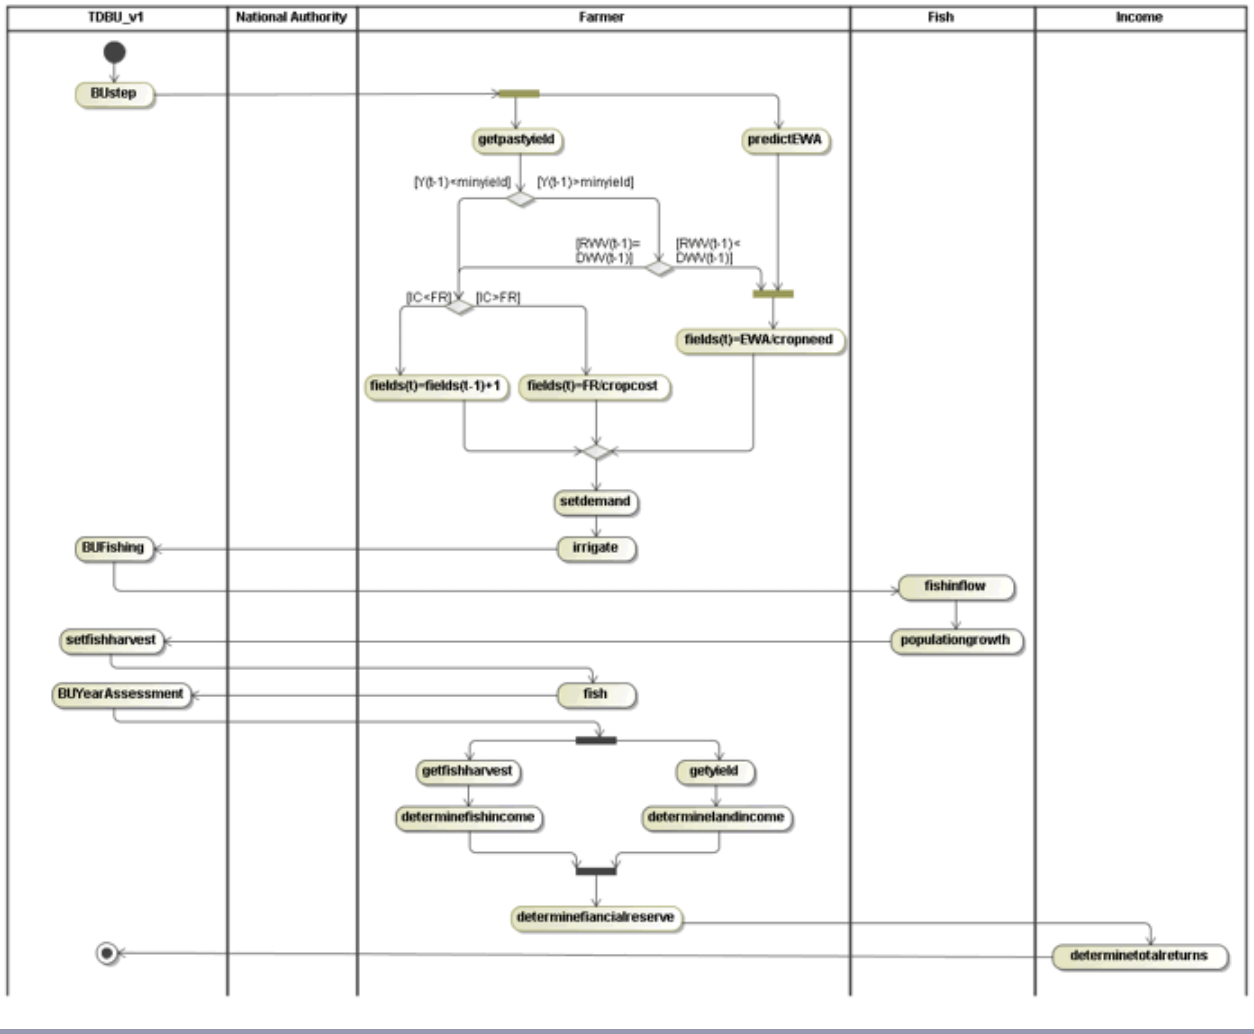
Fig. 6. Activity diagram of the decentralized model. Sequence of activities within 1 yr (t). EWA(t)= expected water availability in mo 7 of yr t, RWV(t)= requested water volume in mo 7 of yr t, DWV(t) = delivered water volume in mo 7 of yr t, Y(t) = yield in yr t, IC = costs of irrigating the total number of fields, FR = financial reserve, cropneed = water needed to irrigate one field of the respective crop, and cropcost = cost of cultivating the crop on one